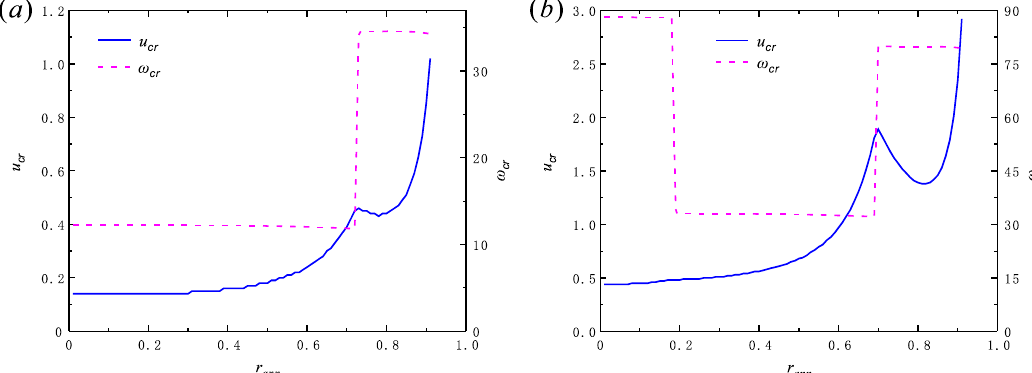
Figure 8. Leaching-tubing-like systems, theoretical variation of u cr and ω cr with the confinement length r ann . The results are based on the instability of the first prediction. ( a ) Leaching-tubing with α ch = 1.676 and ε = 562.5 ( L = 100 m). ( b ) Leaching-tubing with α ch = 1.676 and ε = 1124.9 ( L = 200 m).